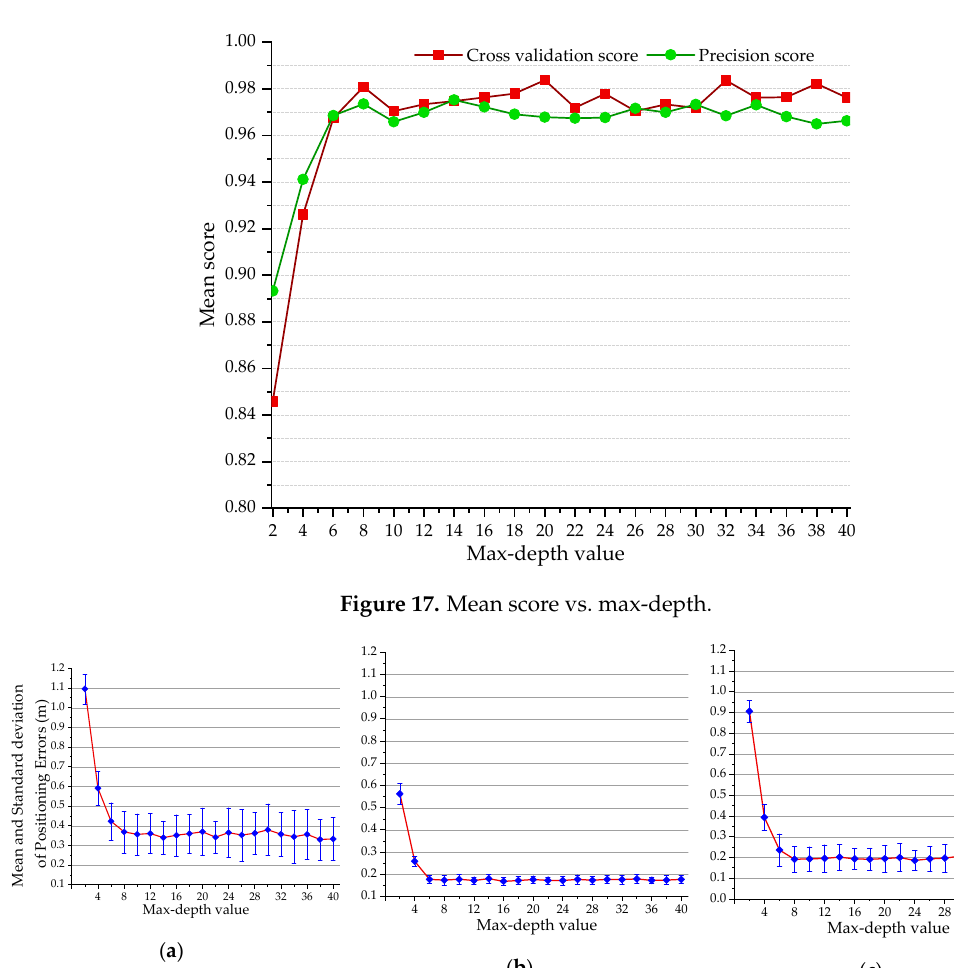
Figure 19. Mean score vs. number of trees.